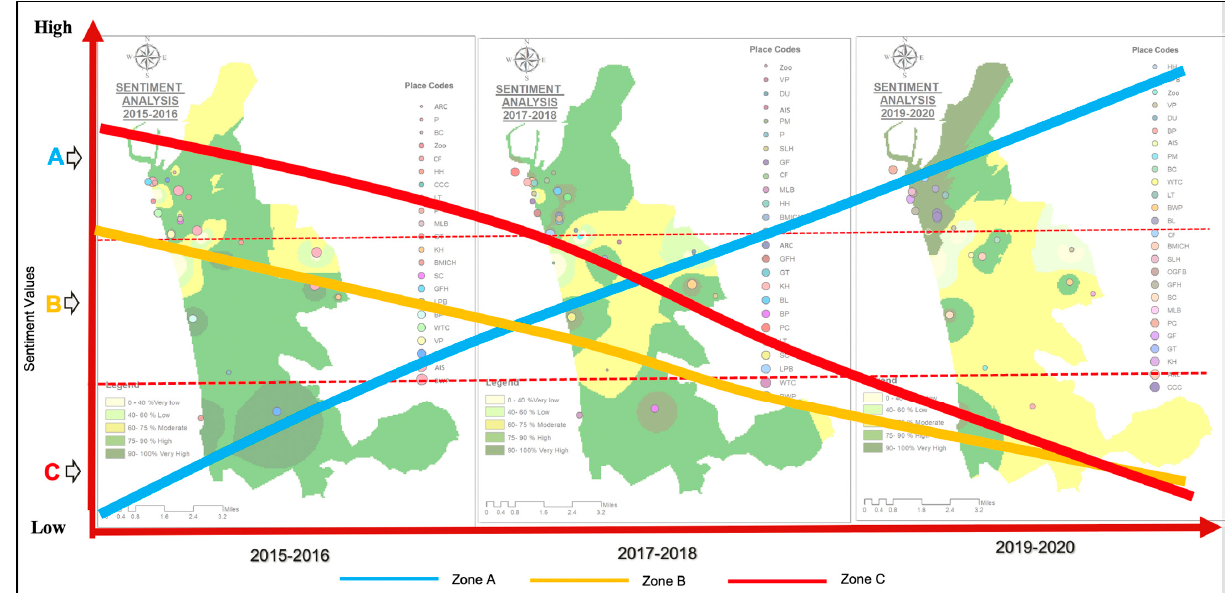
Figure 8. Sceneries of: ( a ) KH shared on Instagram; ( b ) MLB shared on Twitter.